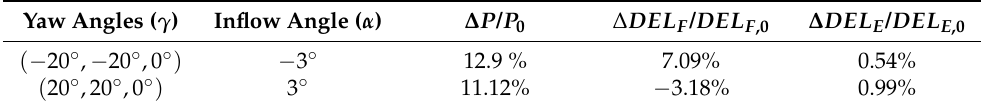
Table 2. Power gains and DEL variations for the configurations with opposite yaw and inflow